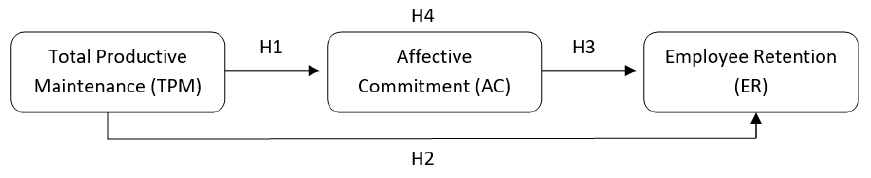
Figure 1. Proposed model.